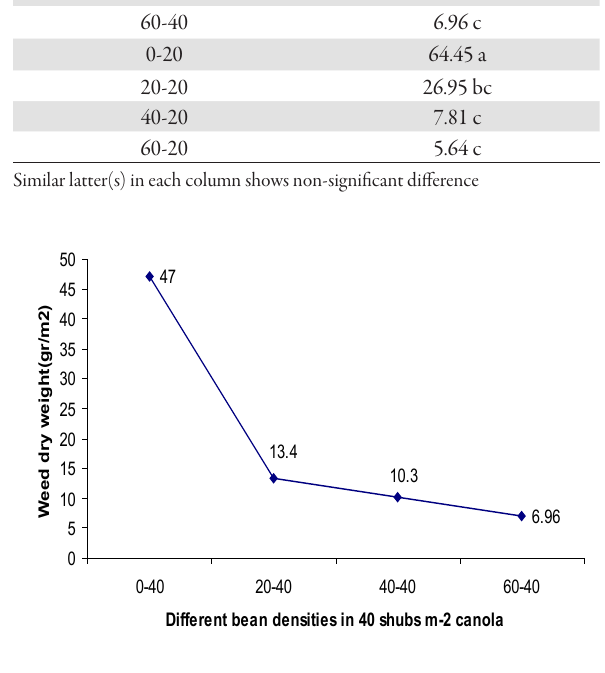
Fig. 1. Effects of different faba bean densities in the intercrop-